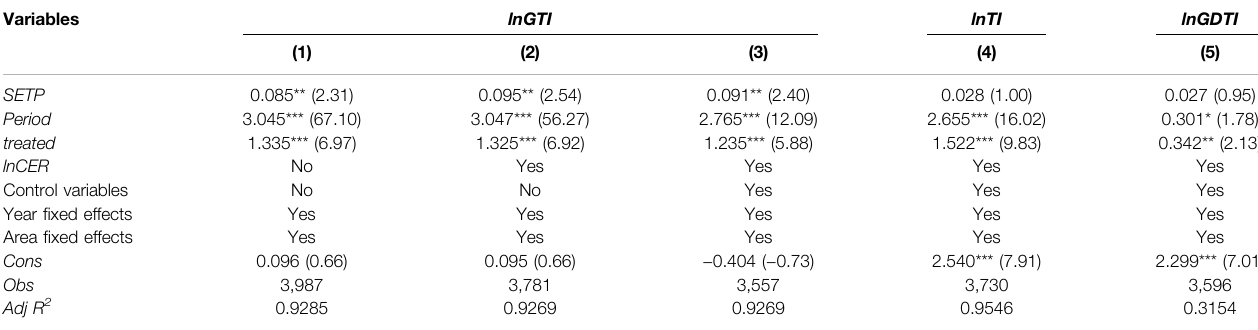
TABLE 2 | Estimation results of the DID model ( SETP ) Variables